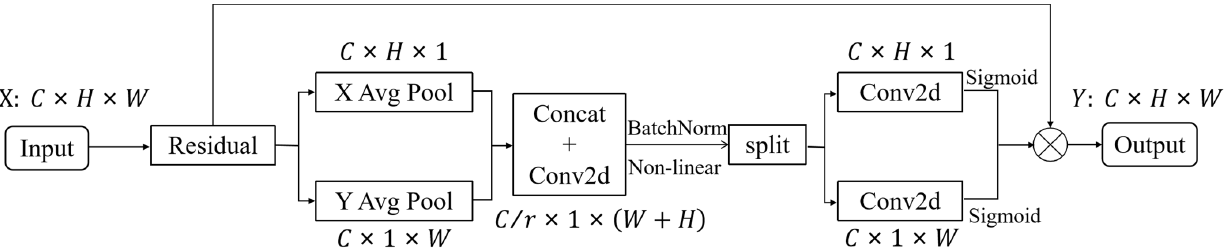
Figure 6. Structure of the CA module.